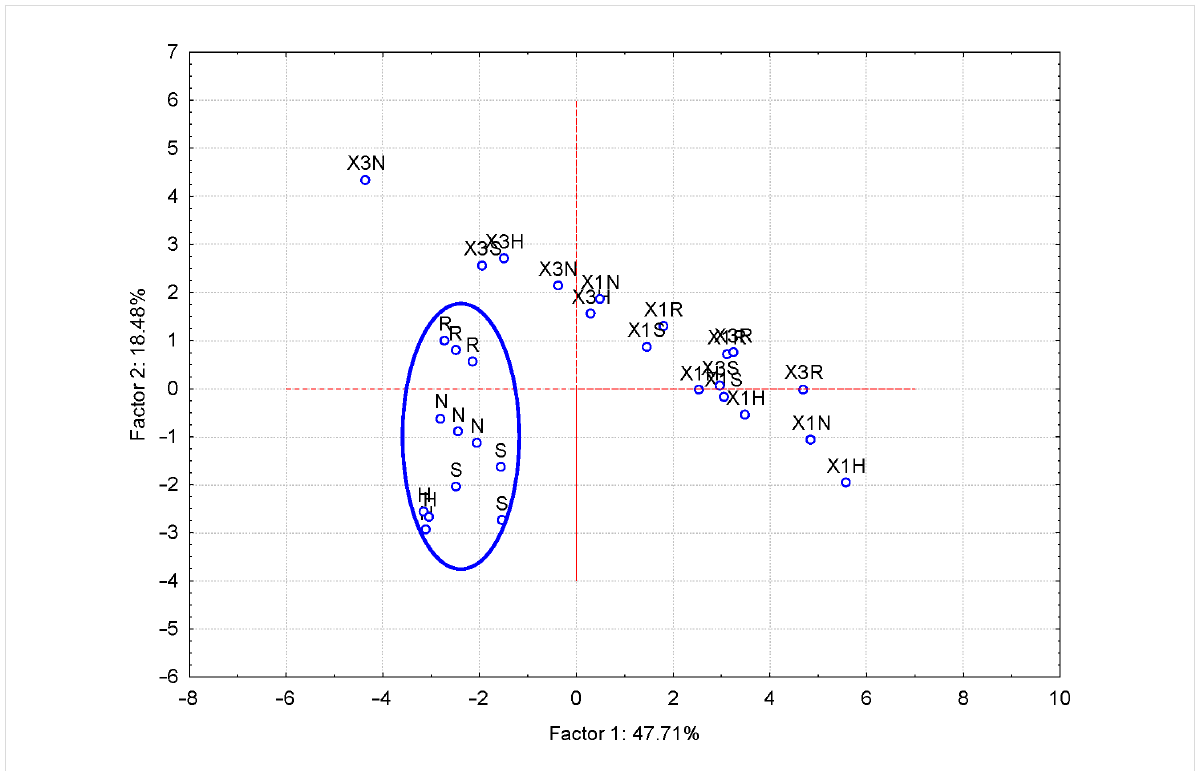
Figure 6: PC 2 versus PC 1 scores plot from the FTIR–PCA analysis of the β -CD/hazelnut oil/flavonoid ternary complexes (codes: “X1H/N/R/S” and “X3H/N/R/S” for the 1:1:1 and 3:1:1 ternary complexes with hesperidin/naringin/rutin/silymarin, respectively) and flavonoids (codes: “H” –